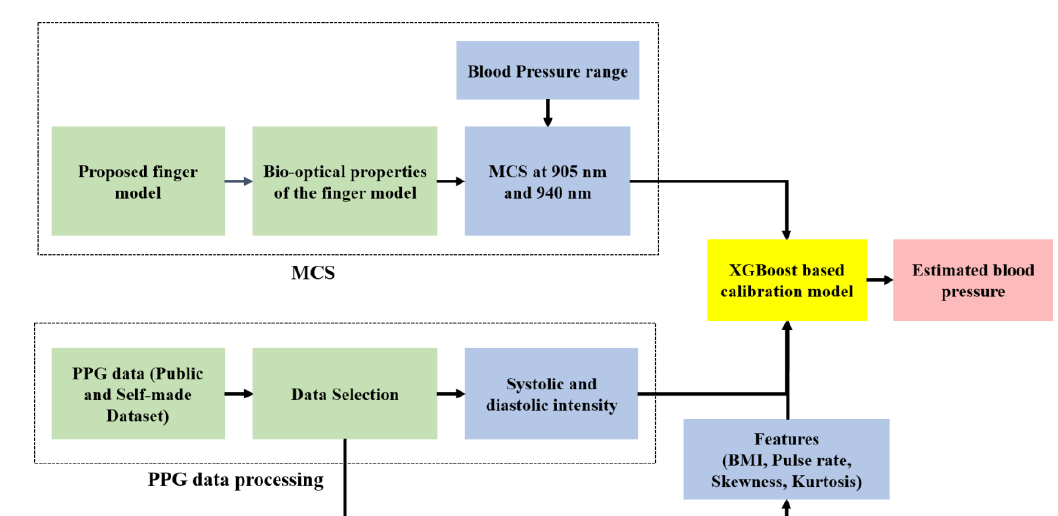
Figure 1. Workflow diagram of the proposed model.